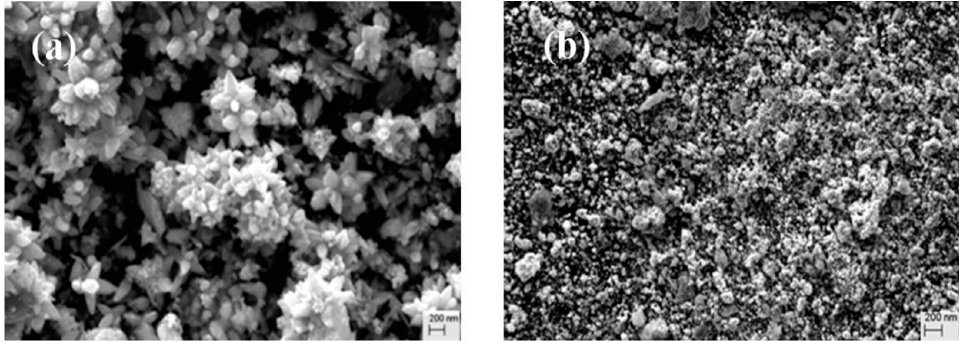
Figure 1. Scanning electron microscopy (SEM) images of ( a ) chemically derived ZnO NPs and ( b ) O. tenuiflorum -mediated ZnO NPs. Adapted from [84].